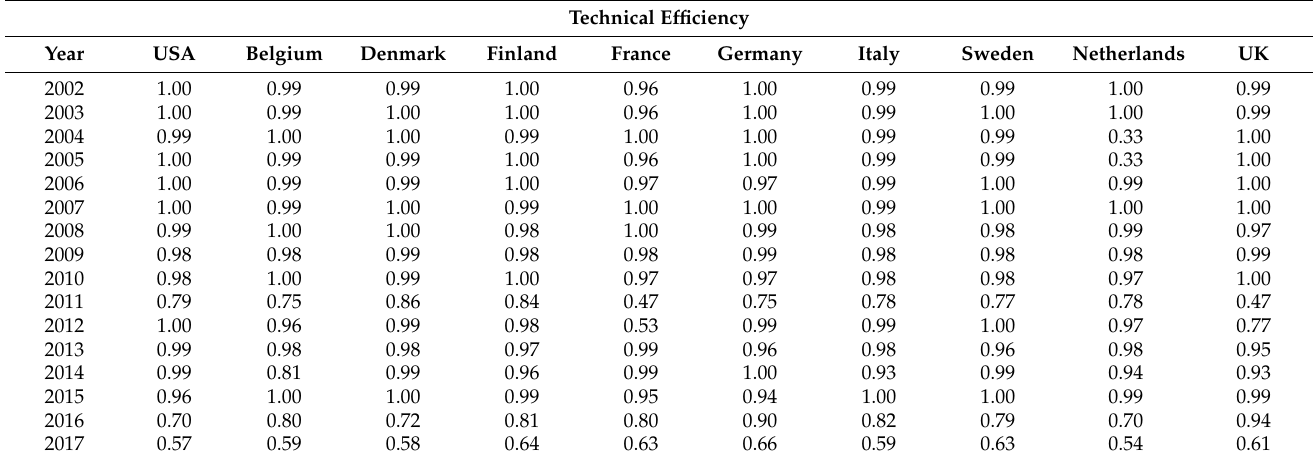
Table 3. DEA models of the technical efficiency.